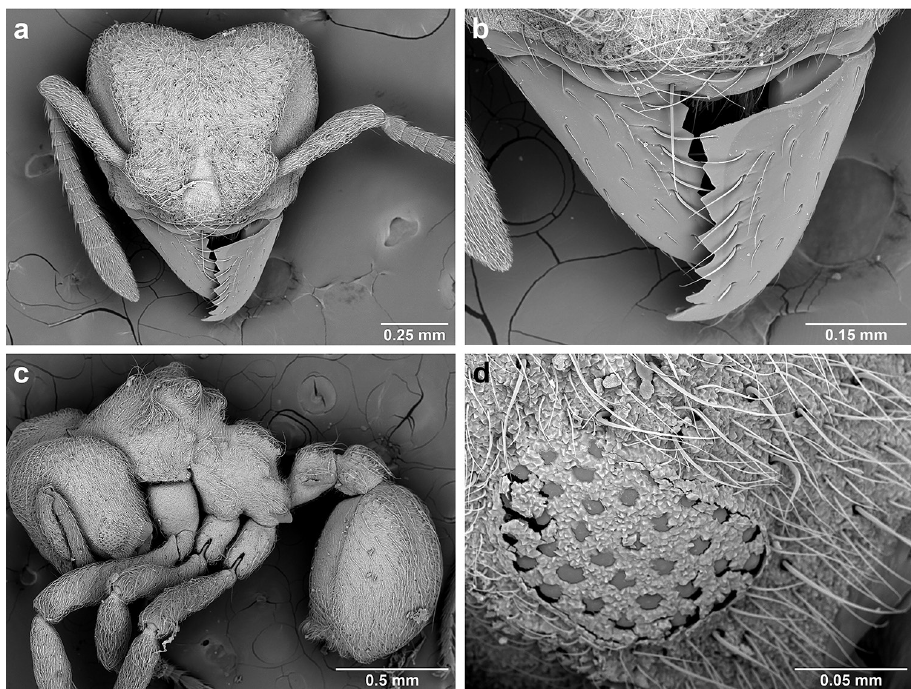
Figure 49. S. parvulus worker (USNMENT01125593), SEM images. a Head, full-face view b mandibles c mesosoma and metasoma, lateral view d